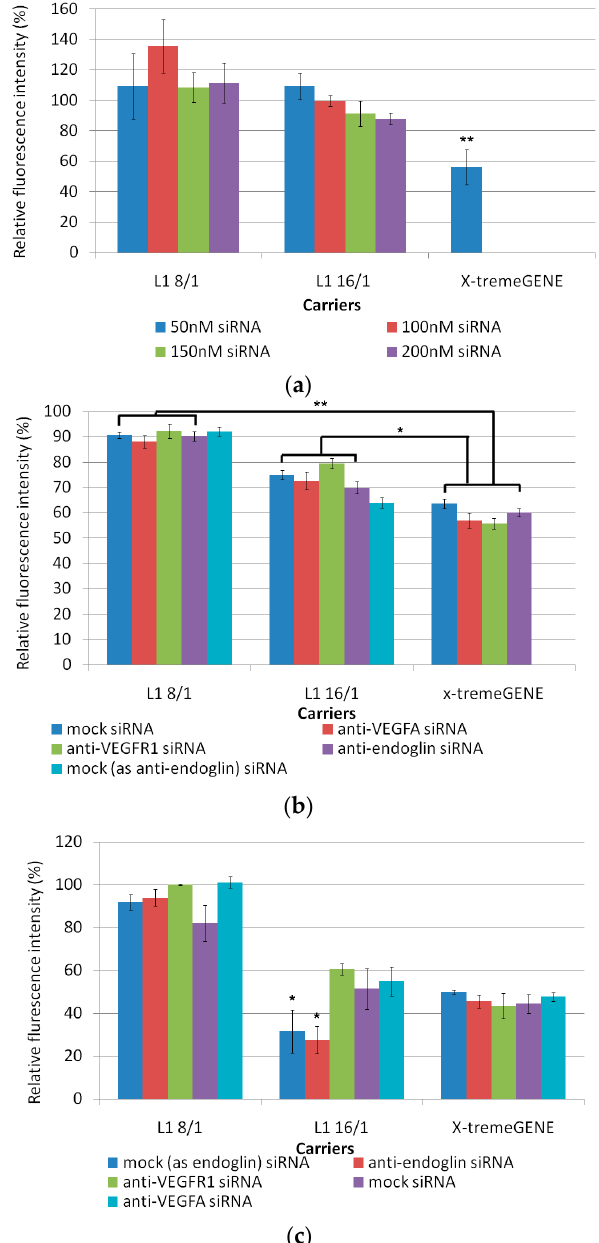
Figure 1. Cytotoxicity evaluation of the siRNA-polyplexes in MDA-MB-231 cells at the low density ( a ), ЕА .Hy926 cells at the low density ( b ) , and ЕА .Hy926 cells at the high density ( c ). * p < 0.05, ** p < 0.01 when compared with X-tremeGENE-lipoplexes.